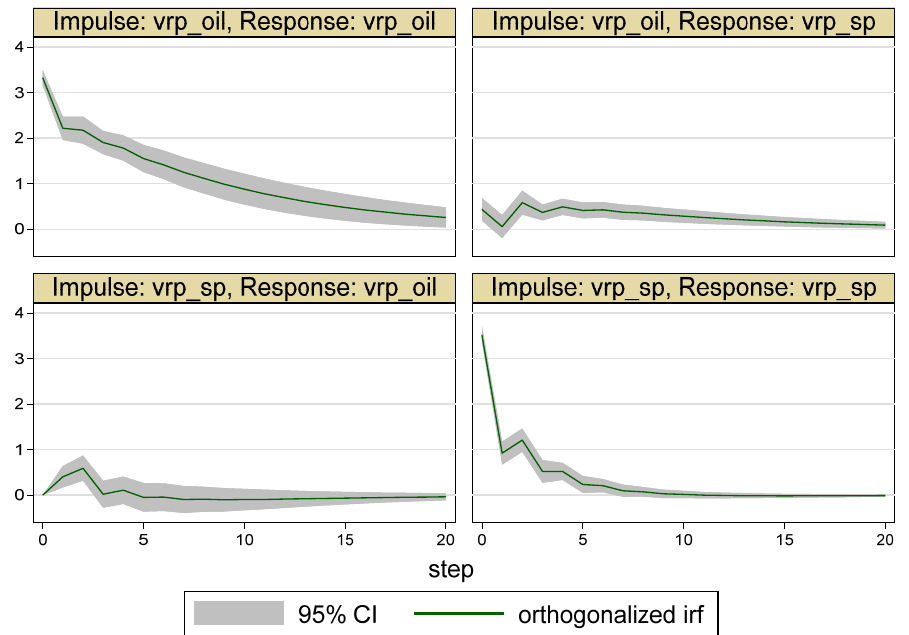
Figure 6. Impulse Response Function (Period 3).